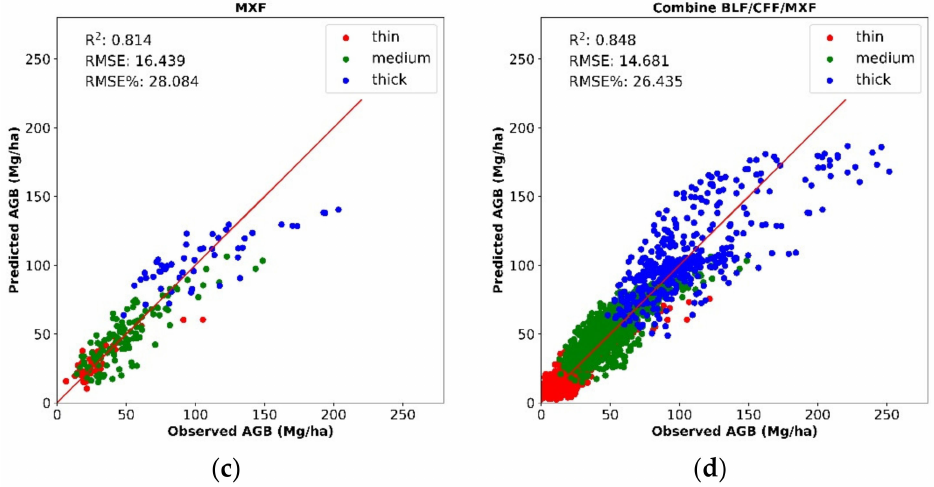
Figure 10. K-DBN model performance (( a ): BLF, ( b ): CFF, ( c ): MXF, ( d ): Combine BLF/CFF/MXF). The LR, RF, DBN, and K-DBN models used in this paper were compared and ana- lyzed, as shown in Figure 11. The K-DBN had the best performance followed by DBN, RF, and LR.